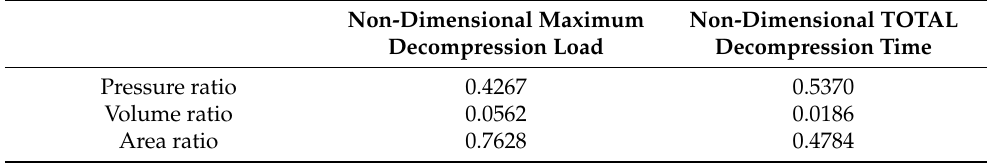
Table 8. Pearson